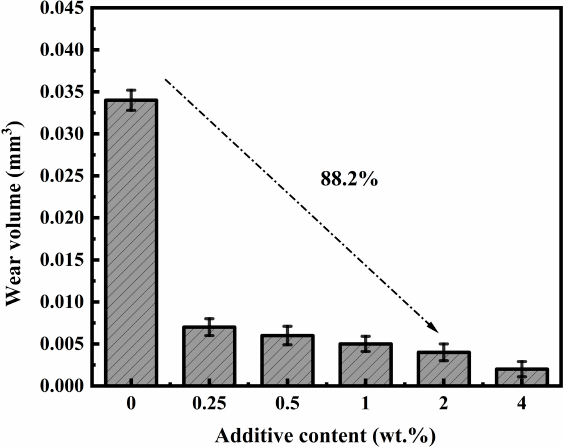
Figure 9. The wear volume of the water scar lubricated by the JD2000 aqueous solutions with different concentrations on the aluminum plates measured using the UMT tribometer.